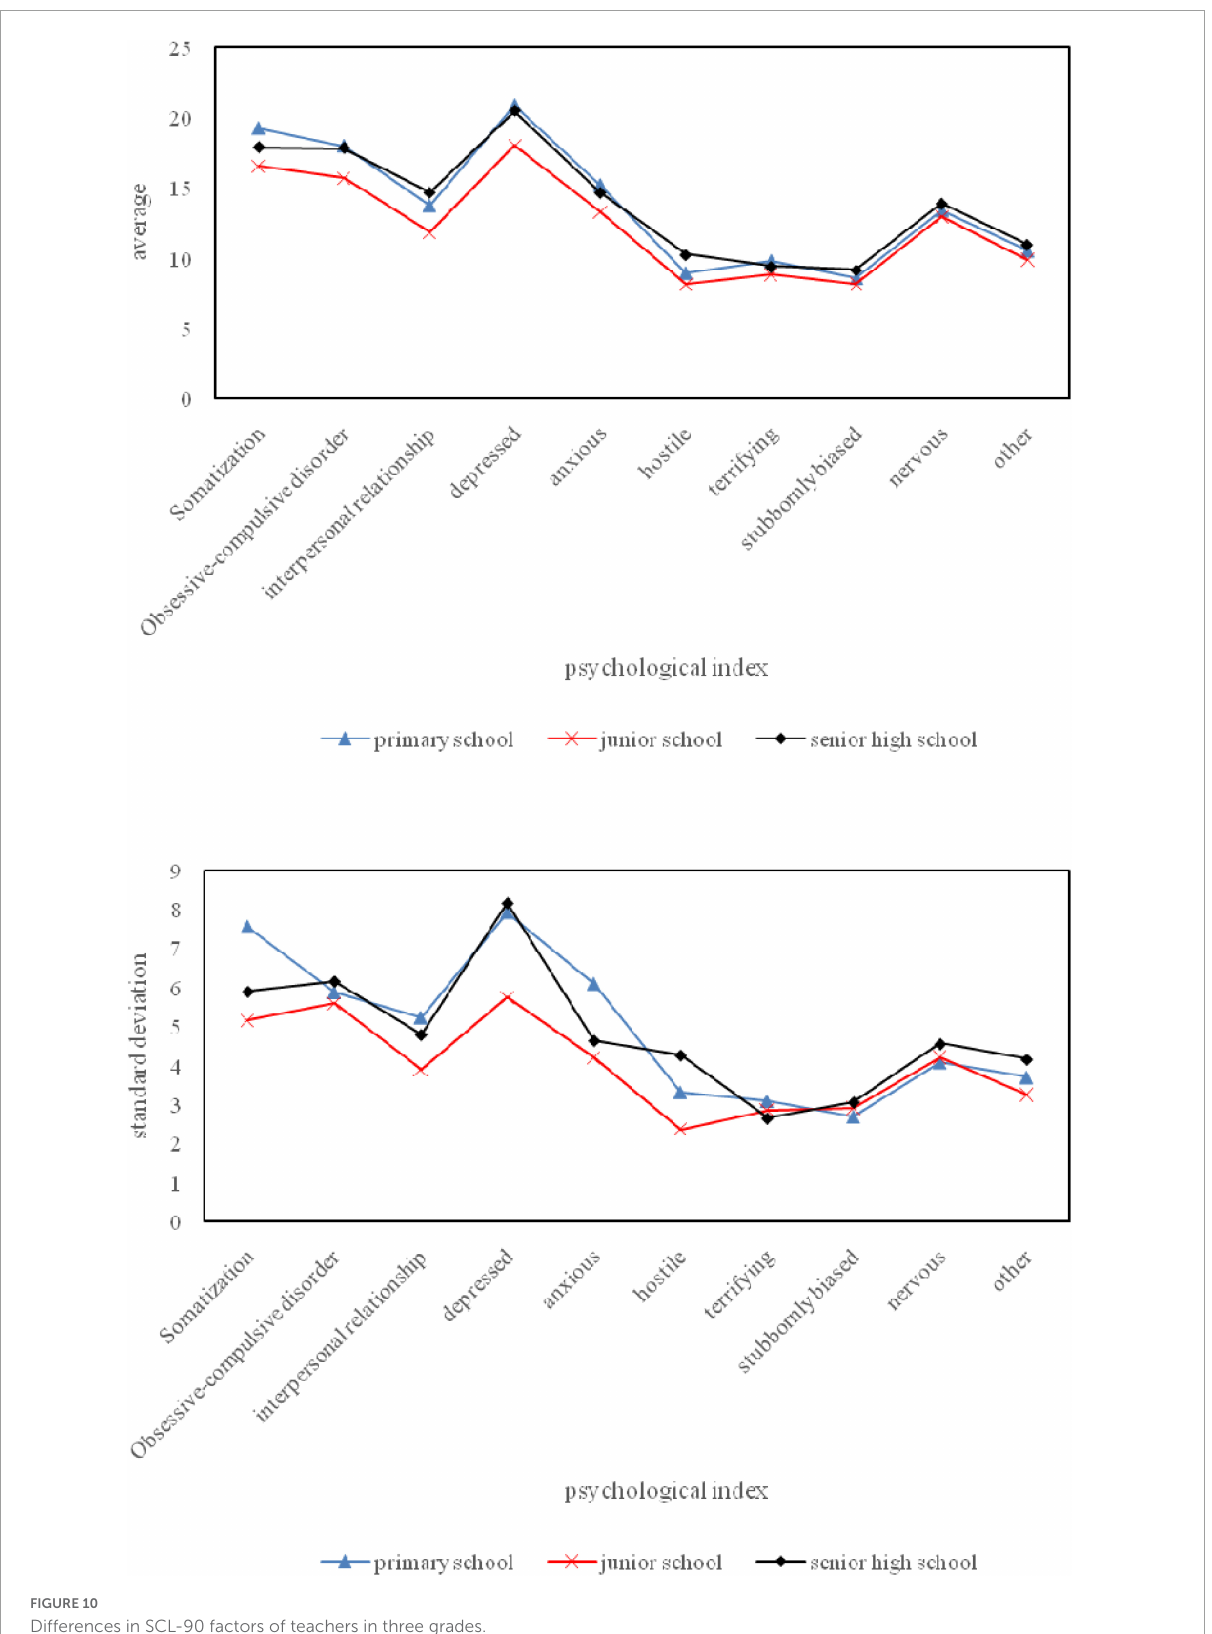
FIGURE10 Differences in SCL-90 factors of teachers in three